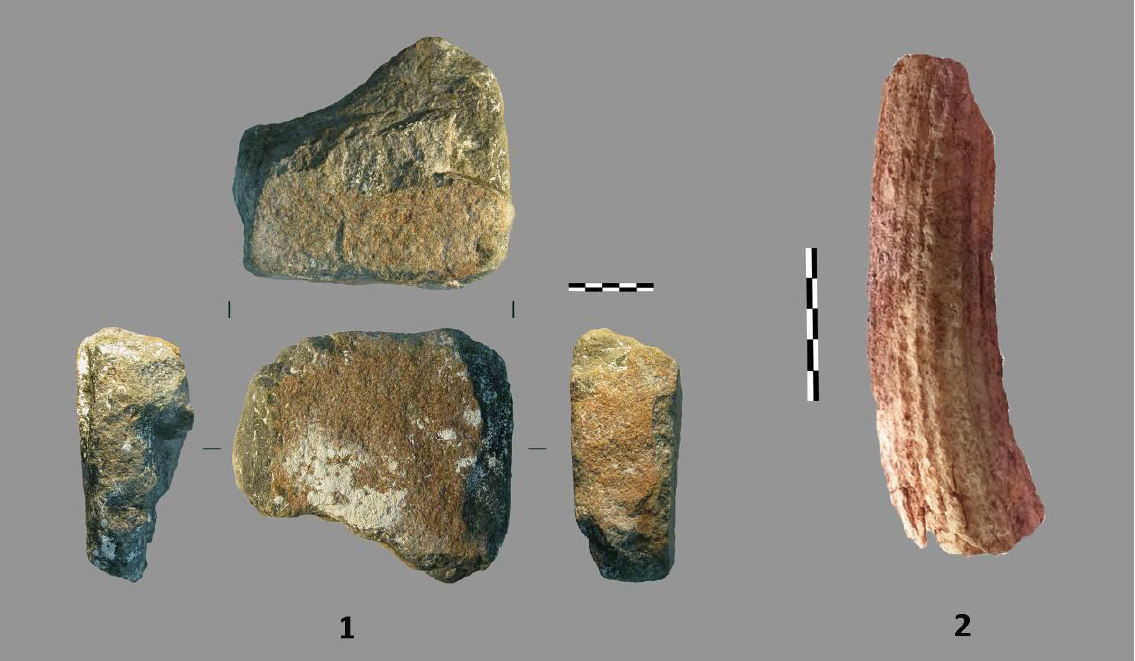
Figure 16. 1. Ophite (dolerite) block employed as a hammerstone. 2. Beveled